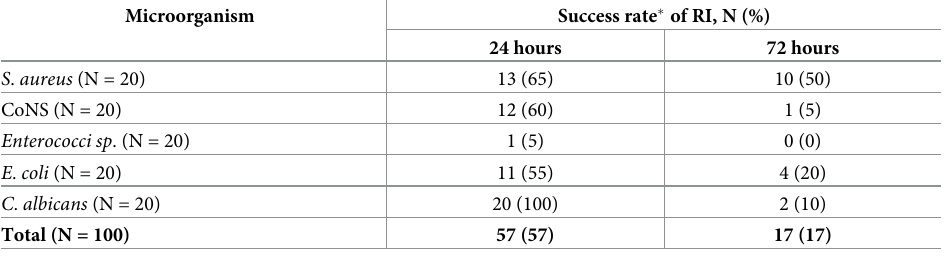
CoNS , coagulase-negative staphylococci. � Success rate for RI was set as �